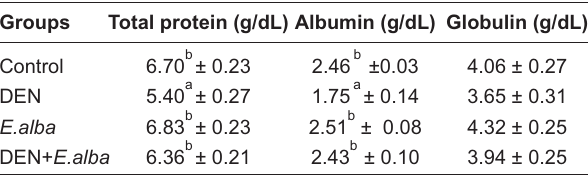
Table- 1: Body weight of control and treated animals (mean ±SE). Groups